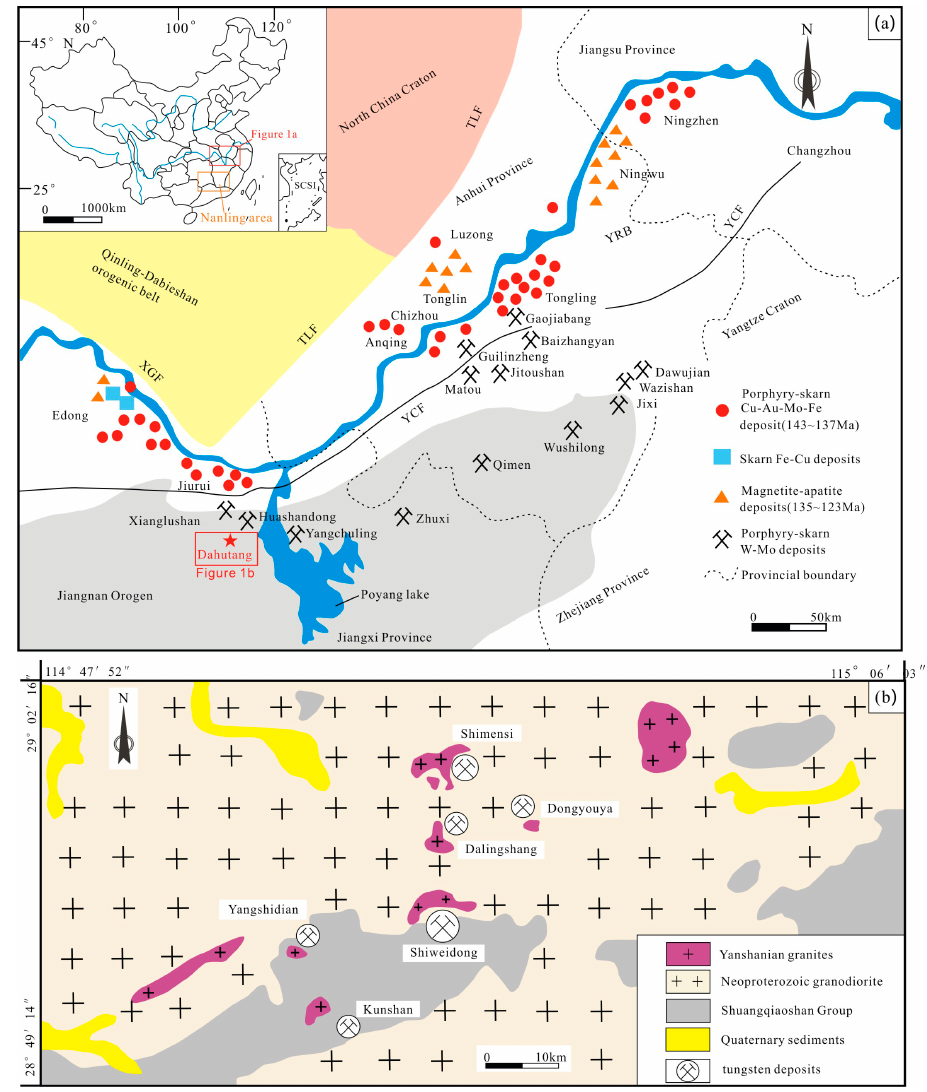
Figure 1. ( a ) Simplified tectonic map showing major Cu-Au-Mo-Fe porphyry and skarn deposits in the Middle-Lower Yangtze River Metallogenic Belt (MLYRB) and ( b ) the Dahutang tungsten ore field (modified after [1]). YCF: Yangxing-Changzhou Fault; TLF: Tancheng-Lujiang Fault; XGF: Xiangfan-Guangji Fault.